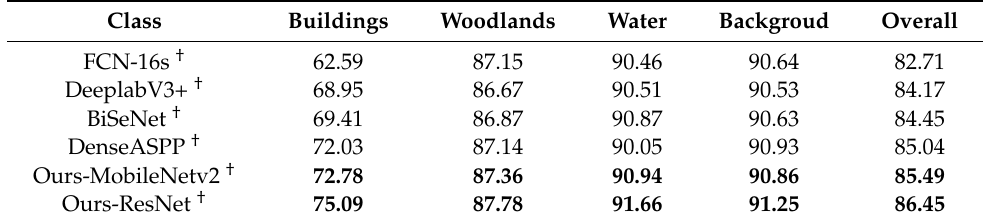
Table 7. Per-class results on LandCover testing set. Methods that are pre-trained are marked with ‘†’ (bold represents the best